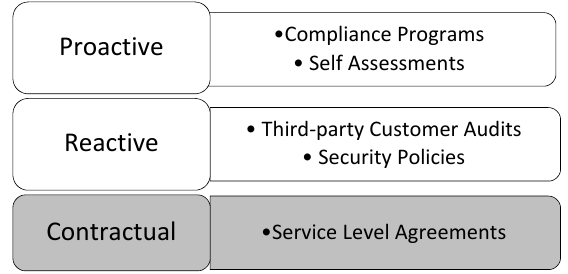
Figure 7. Mechanisms for cloud security transparency.